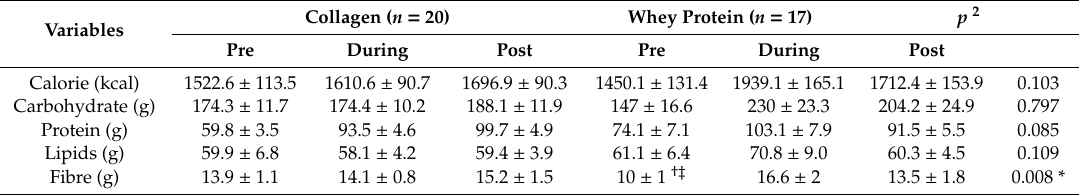
Table 2. Food intake 1 .